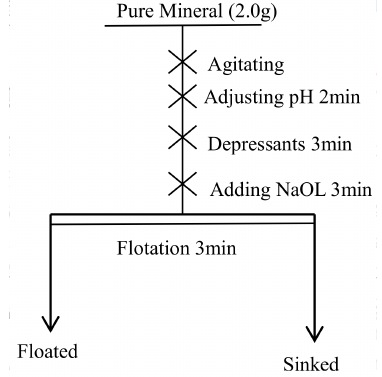
Figure 4. Schematic diagram of pure mineral microflotation